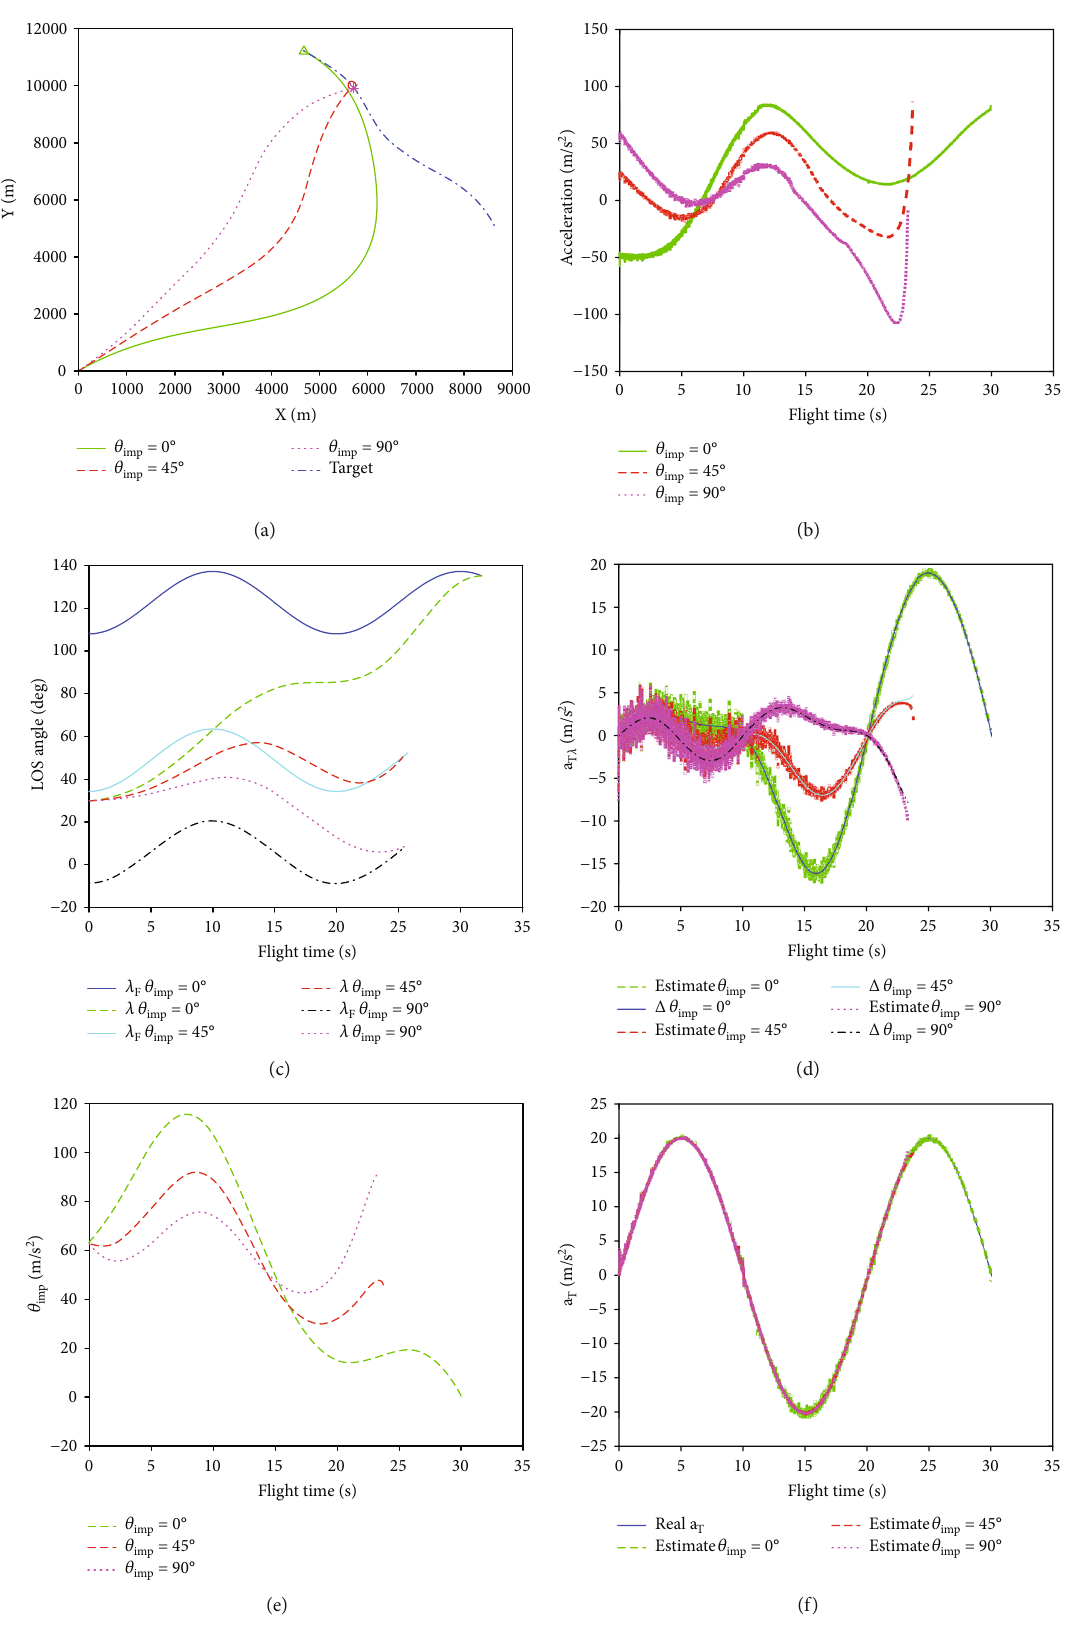
Figure 4: Simulation results under the proposed guidance law for Case 2: (a) interception trajectory; (b) missile achieved acceleration; (c) LOS angle pro fi le; (d) target maneuver projection estimation; (e) impact angle pro fi le; and (f) target maneuver